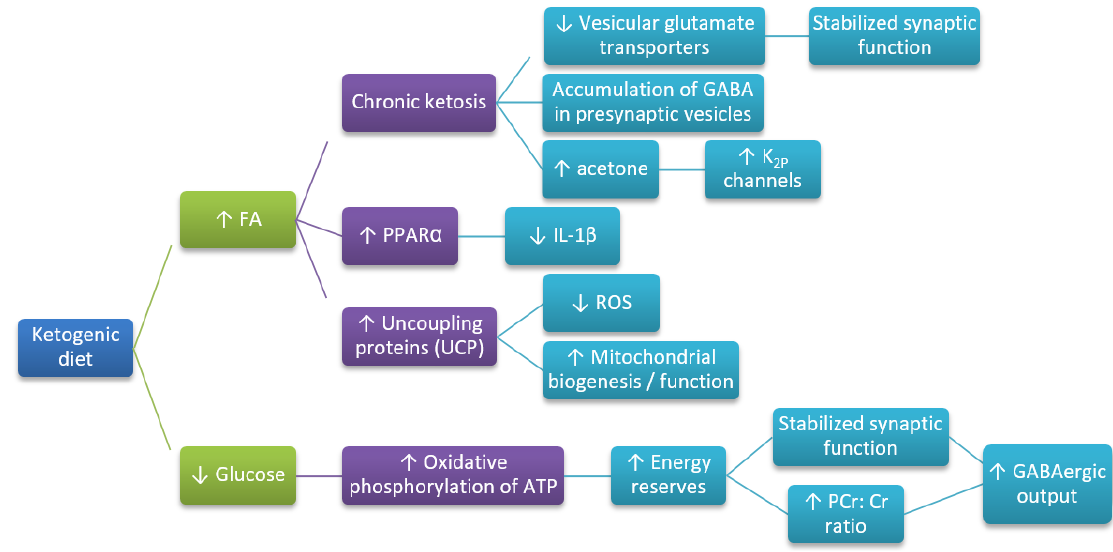
Figure 2. Hypothetical pathways leading to the neuroprotective action of KD (based on References [50,108]). FA—fatty acids; GABA—γ-aminobutyric acid; PCr:Cr—phosphocreatine:creatine ratio; ROS—reactive oxygen species; UCP—uncoupling proteins; increase ( ↑ ) or decrease ( ↓ )—arrows indicate the direction of the relationship between